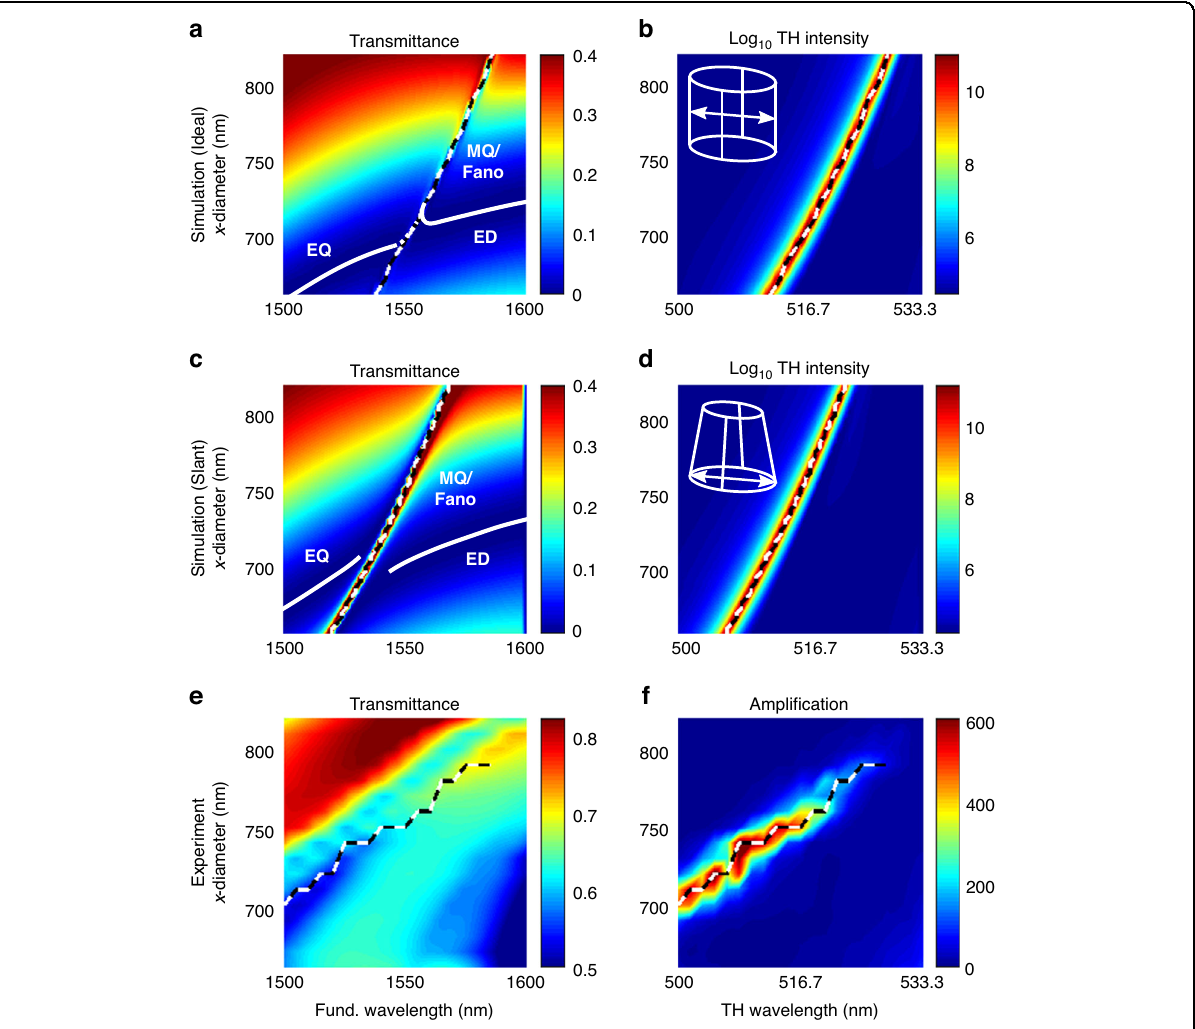
Fig. 4 Transmittance and THG intensity maps. a Calculated spectral transmittance and ( b ) THG intensity maps of the metasurface as a function of the nanodisk elliptical diameter d x with perfectly vertical sidewalls. The dashed curve in both maps marks the linear MQ/Fano resonance, which coincides with the maximum of THG in map ( b ). c , d The same as panel ( a , b ) but for nanodisks with 1° slanted sidewalls. e Corresponding experimental spectral transmittance and ( f ) TH ampli fi cation maps of the fabricated